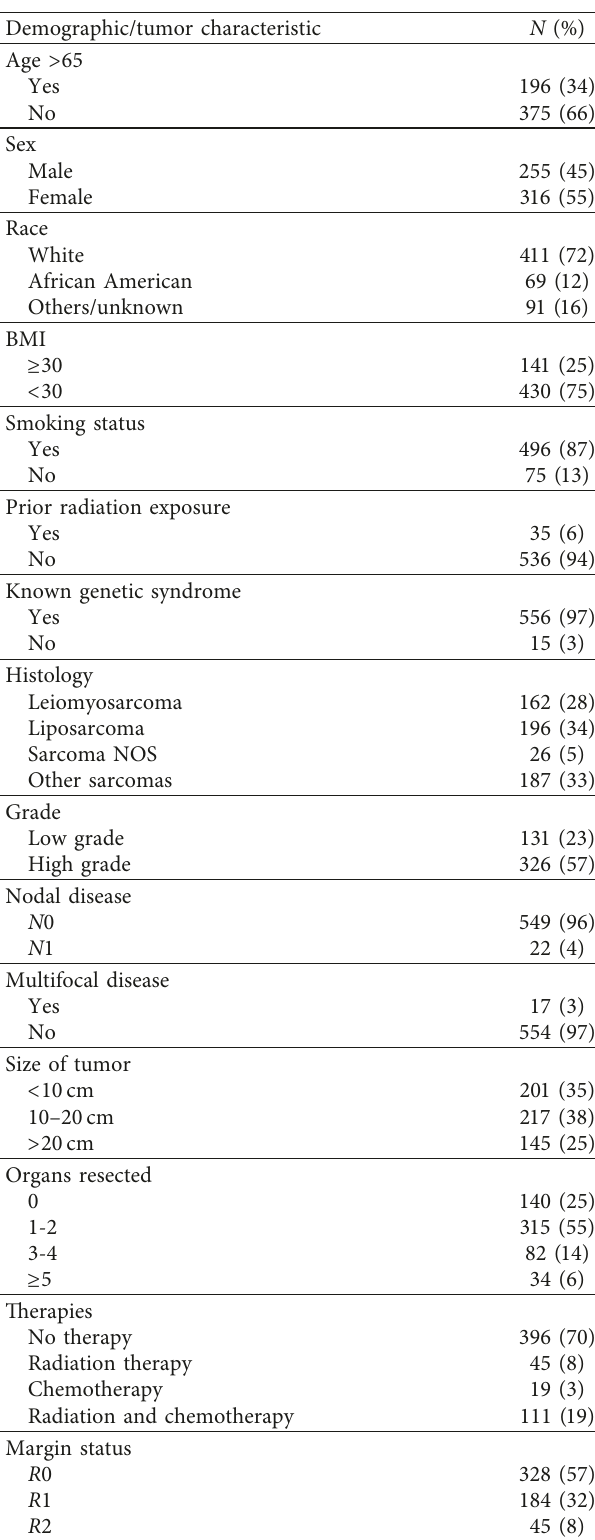
Table 1: Demographic and tumoral data for all patients included in the